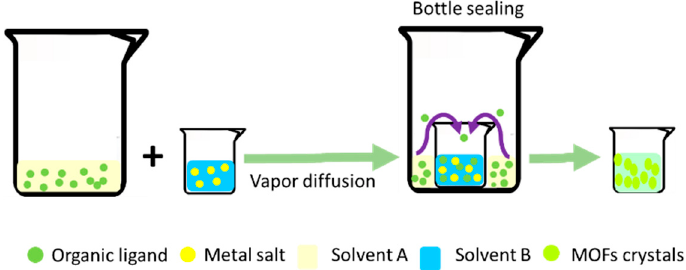
Figure 2. Schematic diagram for MOF synthesis by the gas phase diffusion method.